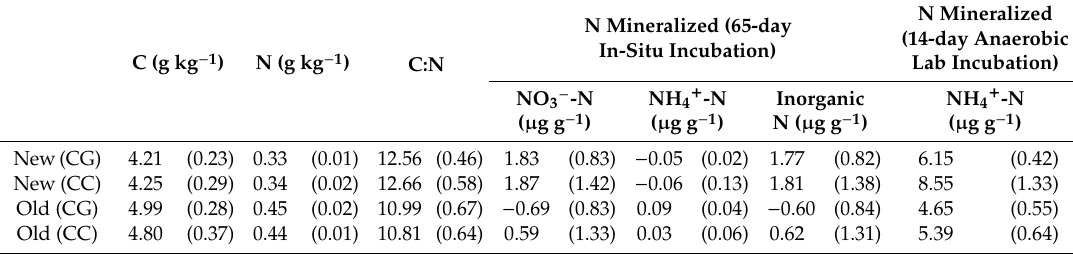
Table 5. Mean ( ± SEM) chemical properties of surface (10 cm; Ah horizon) soil sampled from Canopy Gap (CG) plots and Canopy Closed (CC) plots at the new ( n = 9) and old ( n = 5) infestation sites used for in-situ and laboratory incubation